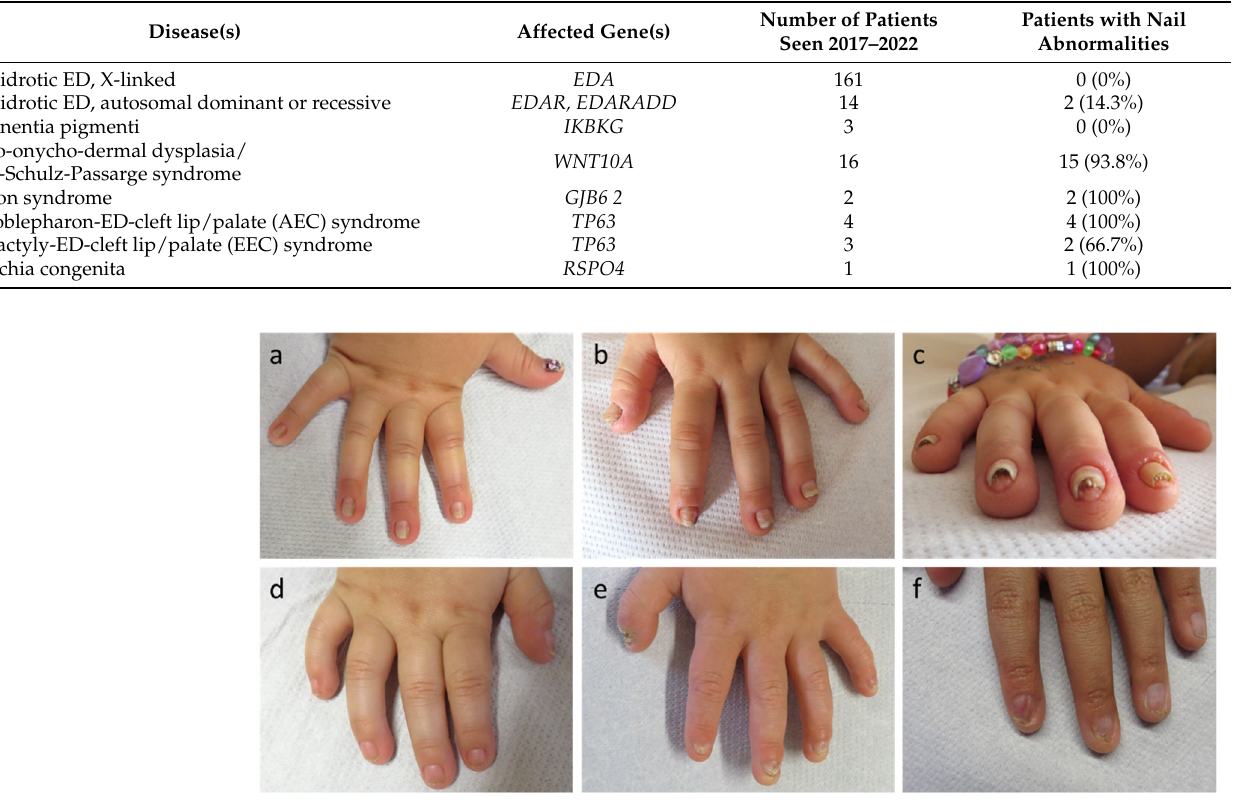
tients with Clouston syndrome; ( d – f ) Spectrum of nail plate abnormalities in p63-associated syn-